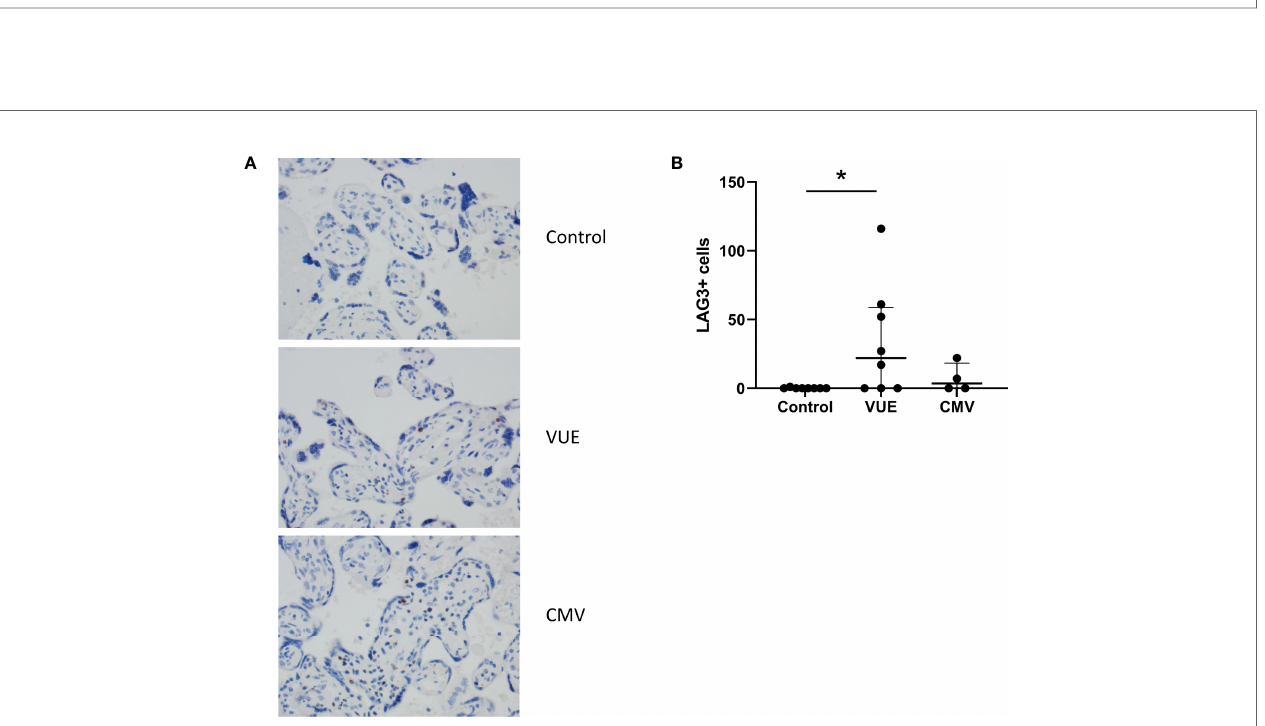
FIGURE 3 | Placental abundance of LAG3+ cells during CMV, VUE and in controls. (A) Representative LAG3 staining in all three groups (200X). (B) Average count of LAG3+ cells image in each group. Median with interquartile ranges are represented in the graph. Signi fi cance was determined by Kruskal-Wallis with false discovery rate correction by Benjamini, Krieger and Yekutieli (n=4-8/group). *p ≤ 0.05.